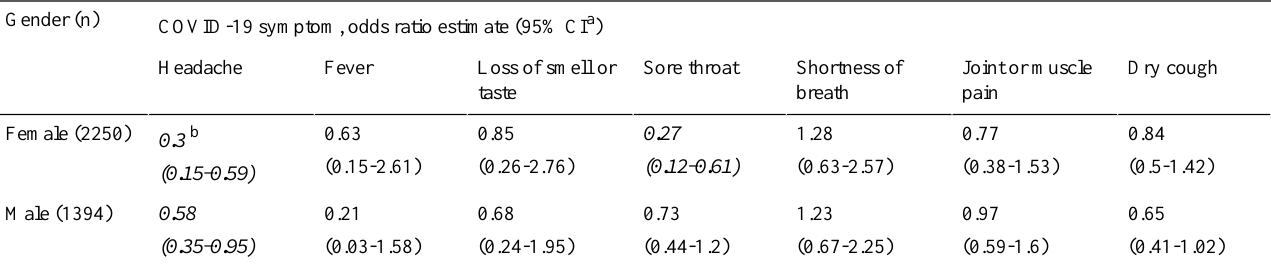
Table 3. Gender-stratified strength of association between statin administration and typical COVID-19 symptoms (n=358). Nonbinary participants (n=3) and those not reporting their gender (n=7) were not included in the analysis due to low numbers. COVID-19 symptom, odds ratio estimate (95% CI a ) Gender (n)